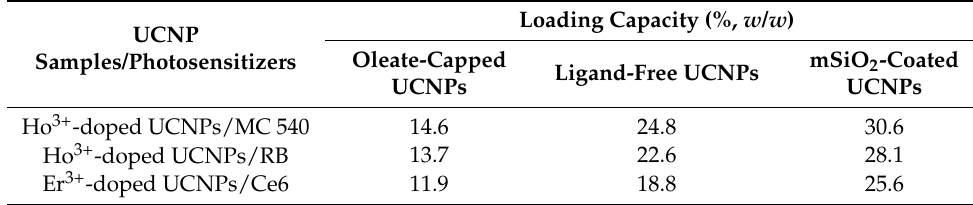
Table 1. Loading capacities for the oleate-capped, ligand-free, and mSiO 2 -coated UCNPs with their corresponding